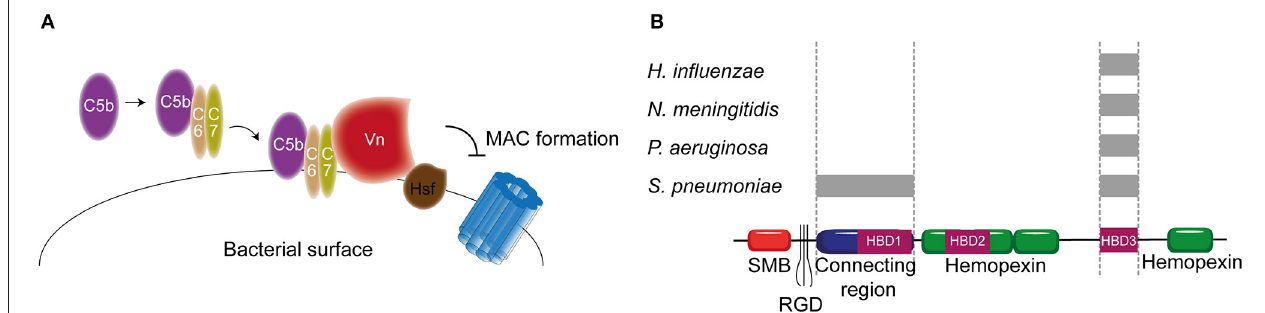
FIGURE 6 | Vn binding by bacterial pathogens. (A) Hsf of H. influenzae binds to the HBD3 of Vn. By recruiting Vn to the bacterial surface, H. influenzae inhibits formation of the MAC. (B) Multiple bacteria can bind Vn at different sites as indicated by the gray rectangles. Bacterial pathogens either interact with Vn’s connecting region or with the C-terminal HBD3. Figure was produced using Servier Medical